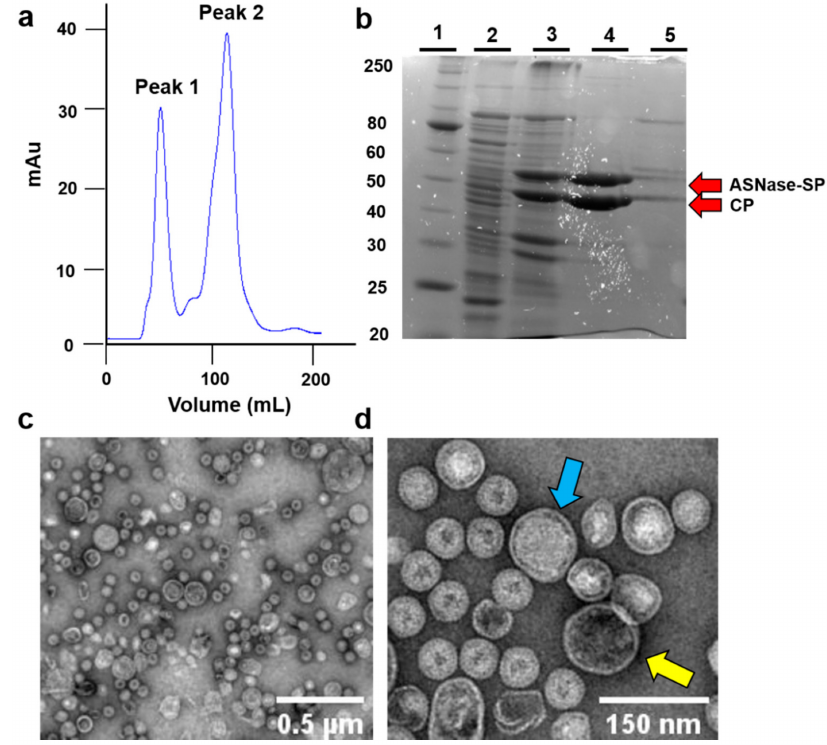
Figure 2. Purification and characterization of ASNase-P22 nanoreactors. ( a ) Size exclusion chro- matogram of the ASNase-P22 purification. Peak 1 shows the eluted fraction where the assembled nanoreactors are found. ( b ) SDS-PAGE of the purification steps of ASNases-P22 nanoreactors. Lane 1, molecular weight marker. Lane 2, non-induced cells lysate. Lane 3, induced cell lysate. Lane 4, eluted fraction corresponding to peak 1 of the chromatogram. Lane 5, eluted fraction corresponding to peak 2 of the chromatogram. Red arrows point out the ASNase-SP and CP bands at 53 kDa and 47 kDa, respectively. ( c , d ) TEM images of ASNase-P22 nanoreactors found in the eluted fraction corresponding to peak 1 of the chromatogram. Blue and yellow arrows point out a stuffed VLP and an empty VLP,